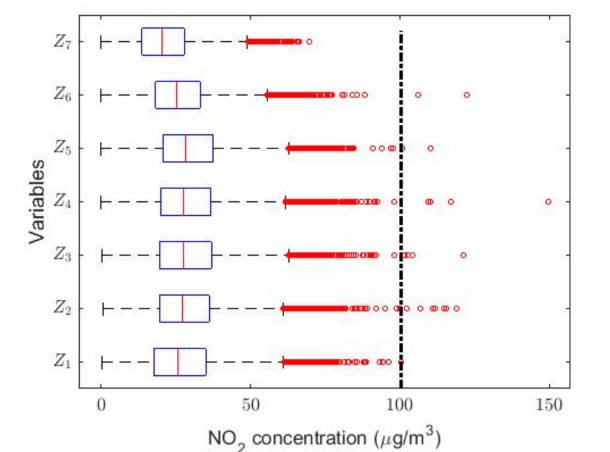
Figure 6. Box plot of data: Z 1 (Monday), Z 2 (Tuesday), Z 3 (Wednesday), Z 4 (Thursday), Z 5 (Friday), Z 6 (Saturday), and Z 7 (Sunday).